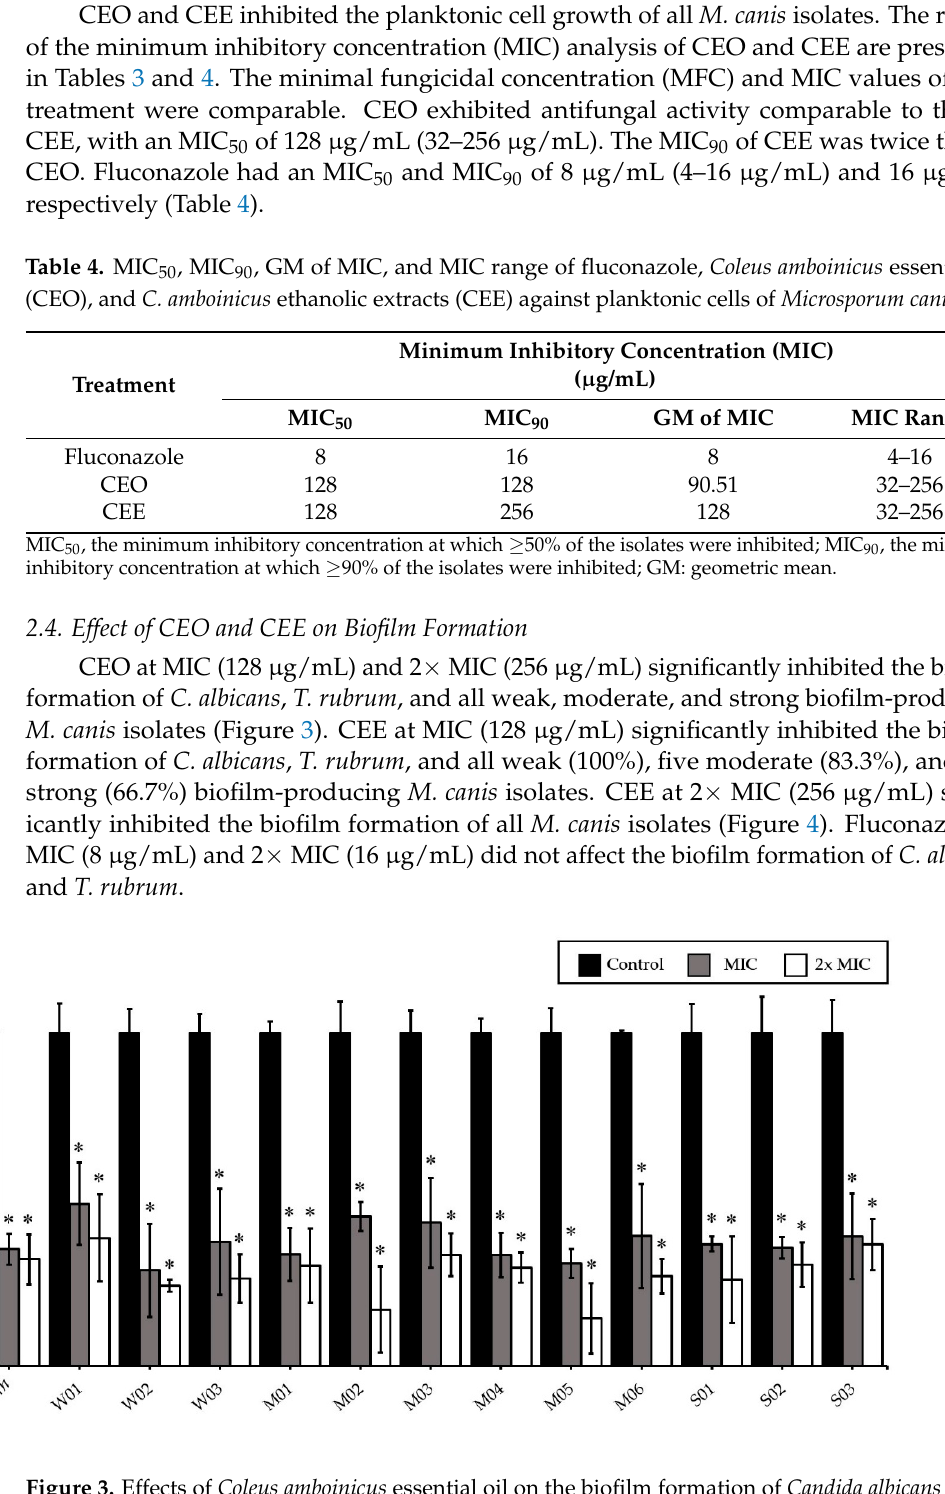
Figure 3. Effects of Coleus amboinicus essential oil on the biofilm formation of Candida albicans ATCC 90028, Trichophyton rubrum, and Microsporum canis after 96 h of treatment. Each bar represents the mean ± SD of three experiments per group. * differences between the control and treatments were statistically significant ( p <